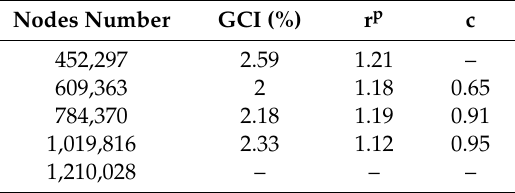
Table 1. GCI convergence